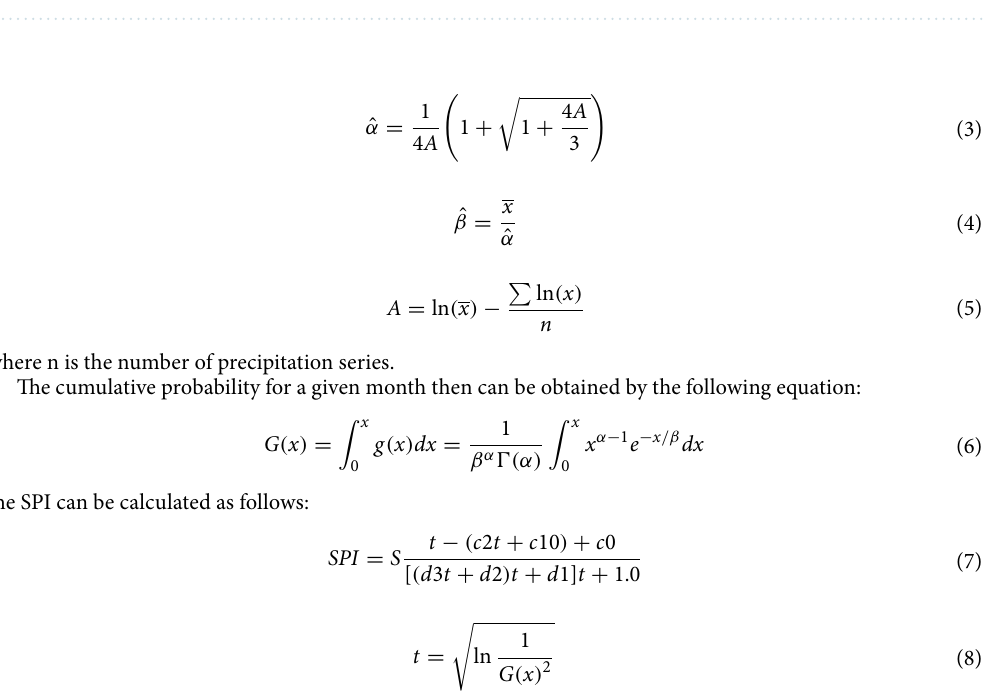
Table 1. Climatic moisture categories for the SPI and SPEI 2